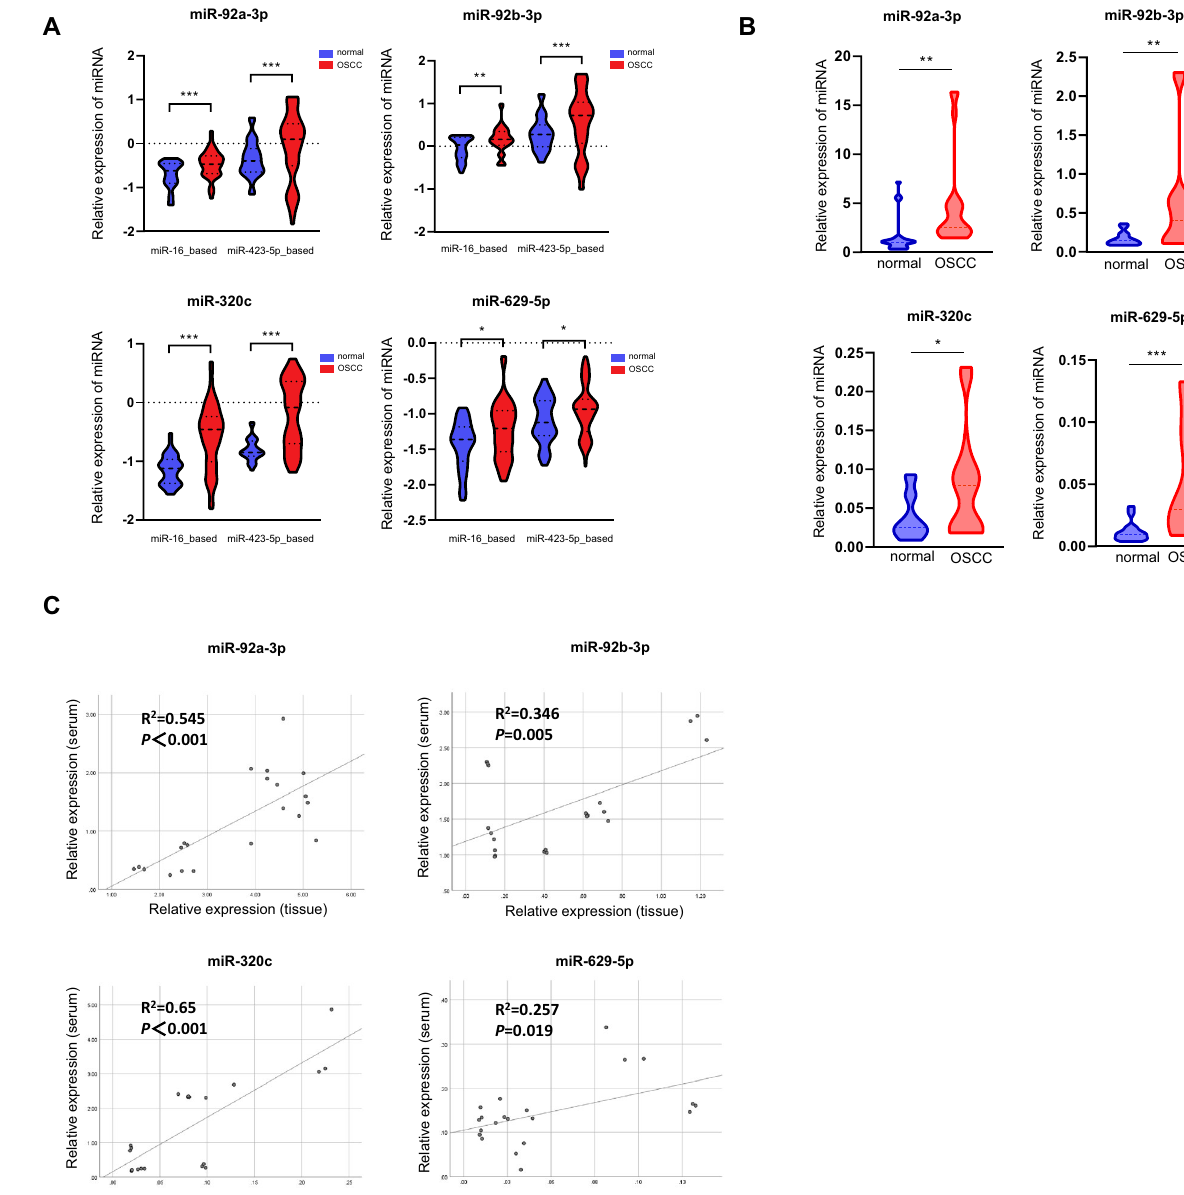
Figure 2. qRT-PCR validation data of selected differentially expressed miRNAs. ( A ) Serum samples. The expression levels of miRNAs were calculated using the 2 -ΔΔCT method, and the results are presented as relative log 10 fold changes. ( B ) Tissue samples. Three biological duplicates were included for each condition. Significantly deregulated miRNA expression was found in patients with oral squamous cell carcinoma (OSCC) versus the healthy controls. ( C ) Scatter plots showing the relative expression of 4 miRNAs in OSCC serum and tissue samples (Pearson